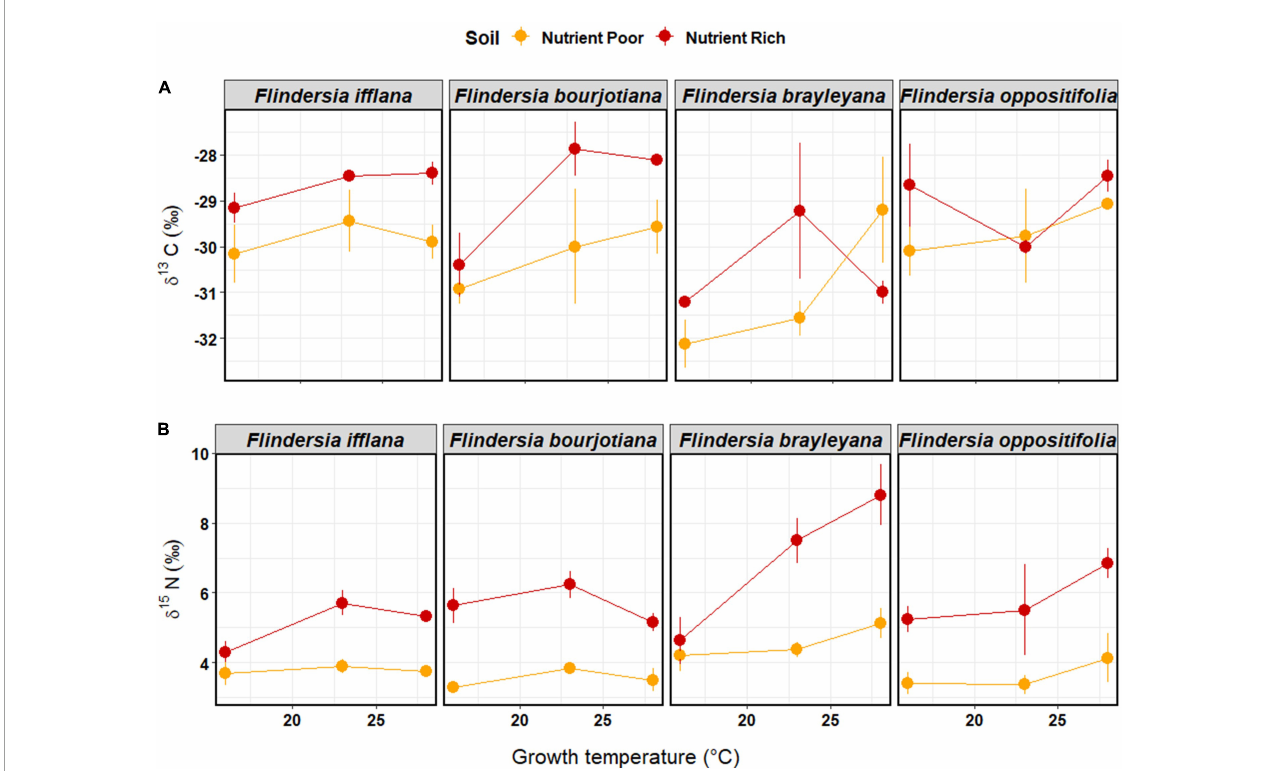
FIGURE4 Means ( ± 1SE) of (A) leaf δ 13 C ( ) and (B) leaf δ 15 N ( ) among temperature and soil nutrient treatments (nutrient-rich soil = red, nutrient-poor soil = orange) in the glasshouse experiment. Each dot represents a mean of three individual saplings. Species are arranged left to right according to their (cid:104) (cid:104) observed elevation ranges, with leftmost being lowland and rightmost being